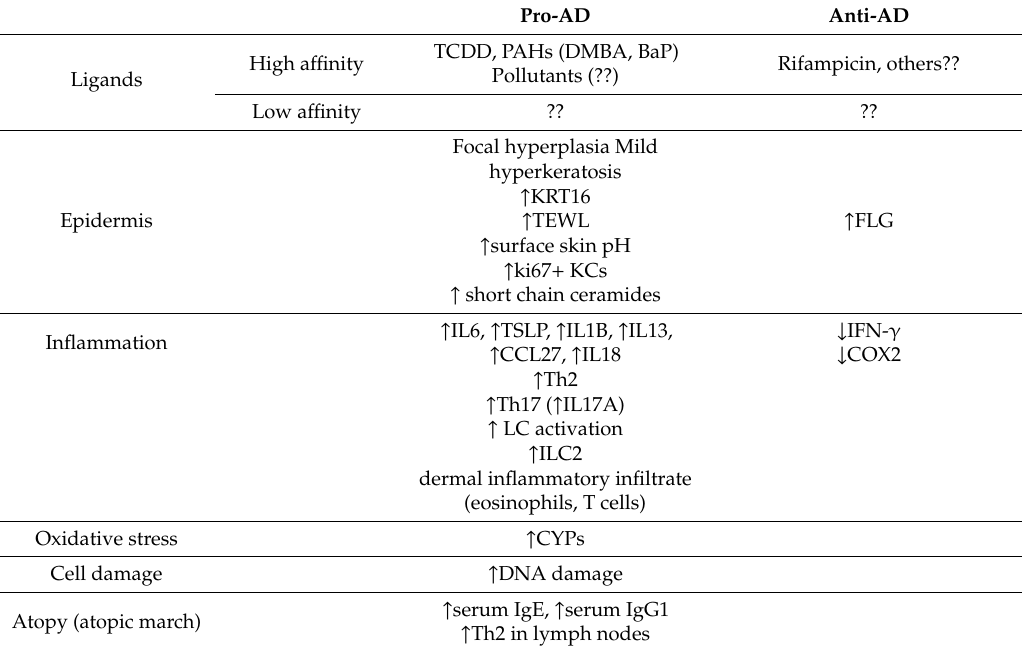
Table 2. Dual e ff ects of PXR in atopic